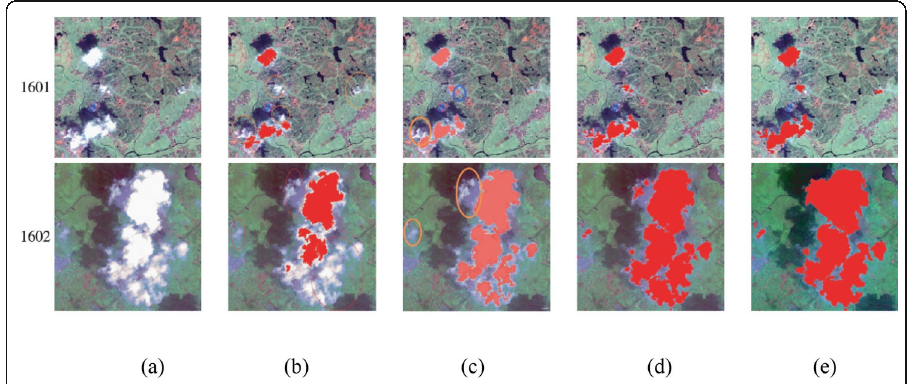
Fig. 5 Comparison of cloud detection algorithm results in remote sensing images. a Original image. b Region growth method. c SVM. d New method. e Real